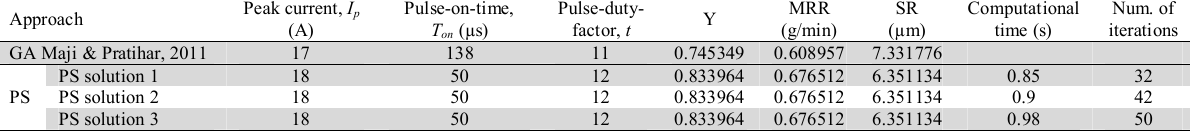
Pulse-duty- Peak current, I p Pulse-on-time, factor, (A) T on (µs)